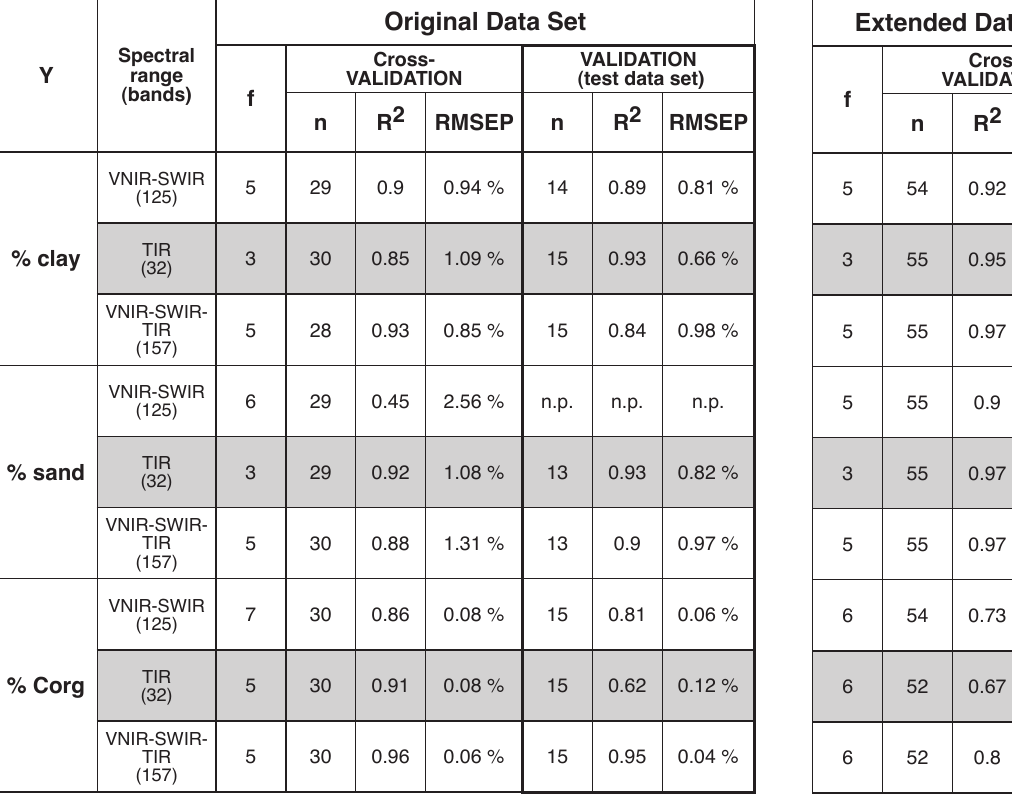
Table 1. Summary of PLSR modelling validation results (internal cross-validation and external validation using a test dataset) for each of the soil properties in the specific spectral region for the original and the extended dataset: number of samples ( n ), number of used model factors ( f ), coefficient of determination ( R 2 ), root mean square error of prediction ( RMSEP ), not possible due to unstable model